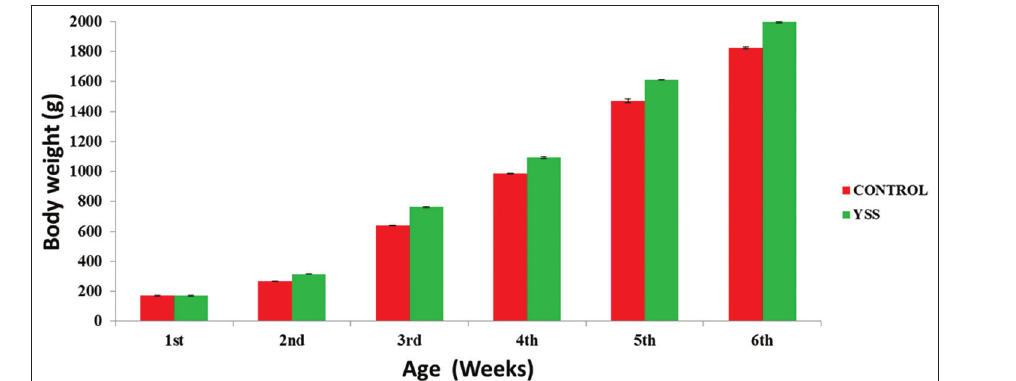
Figure-1: Effect of Yucca treatment on weekly average body weight of broiler chicks in winter season.